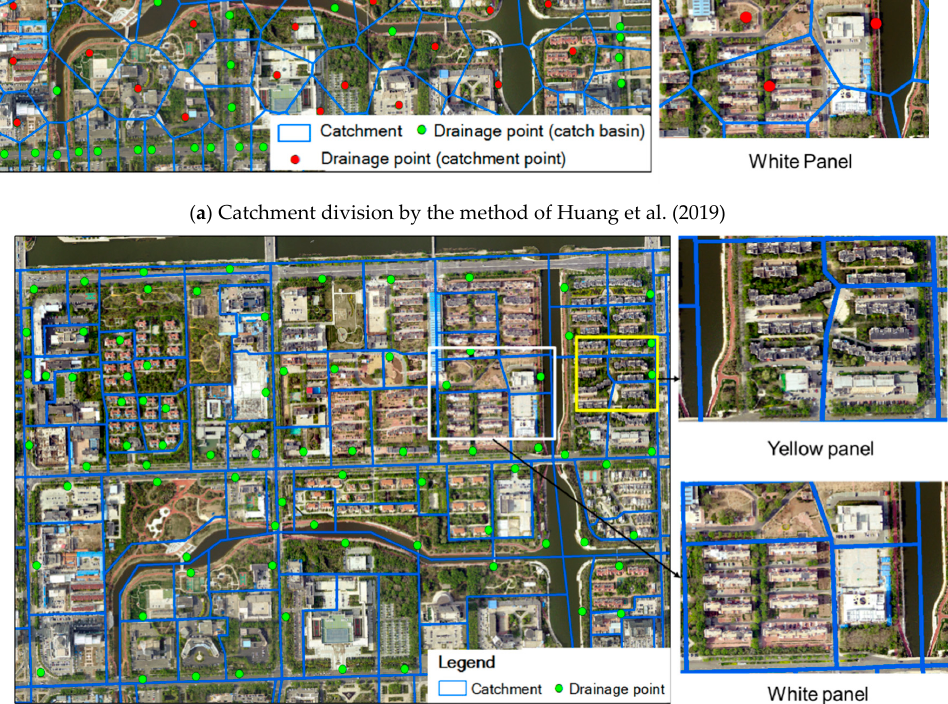
Figure 14. Comparison between the catchment division method of this paper and that of Huang et al. Figure14. ComparisonbetweenthecatchmentdivisionmethodofthispaperandthatofHuangetal.[18], ( a ) denotes the result by Huang et al., ( b ) denotes the result by our